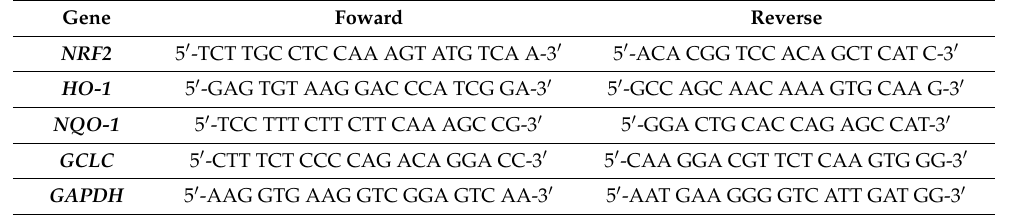
Table 1. Primer sets for real-time